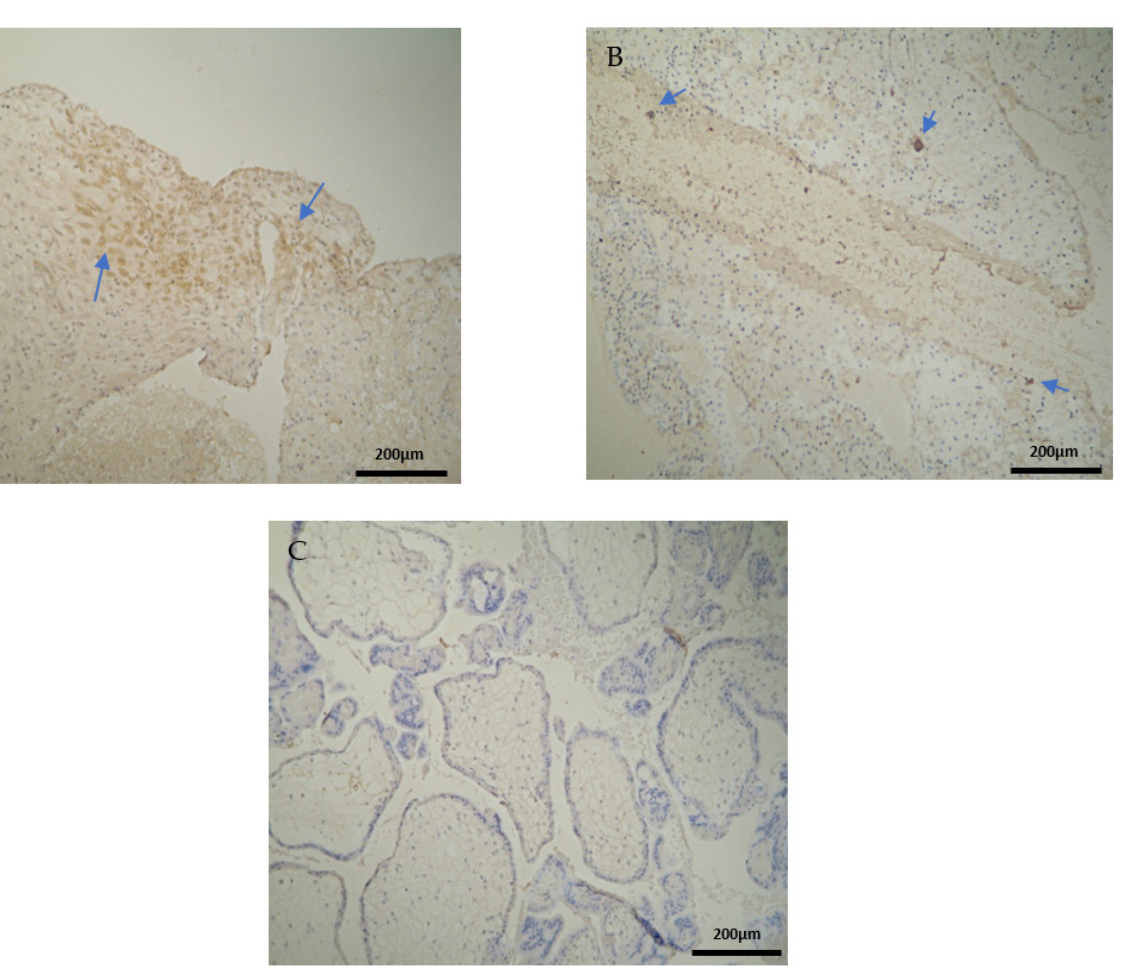
Figure 1. Evaluation of positive CD3 antigen expression. Miscarriage Experimental Group (EG): ( A ) Moderate CD3 + expression in the decidua parietalis (4 × 10 magnification). ( B ) Moderate CD3 antigen expression in the decidua basalis (4 × 10 magnification). ( C ) Chorionic villi sample with negative CD3 antigen expression (4 × 10 magnification).